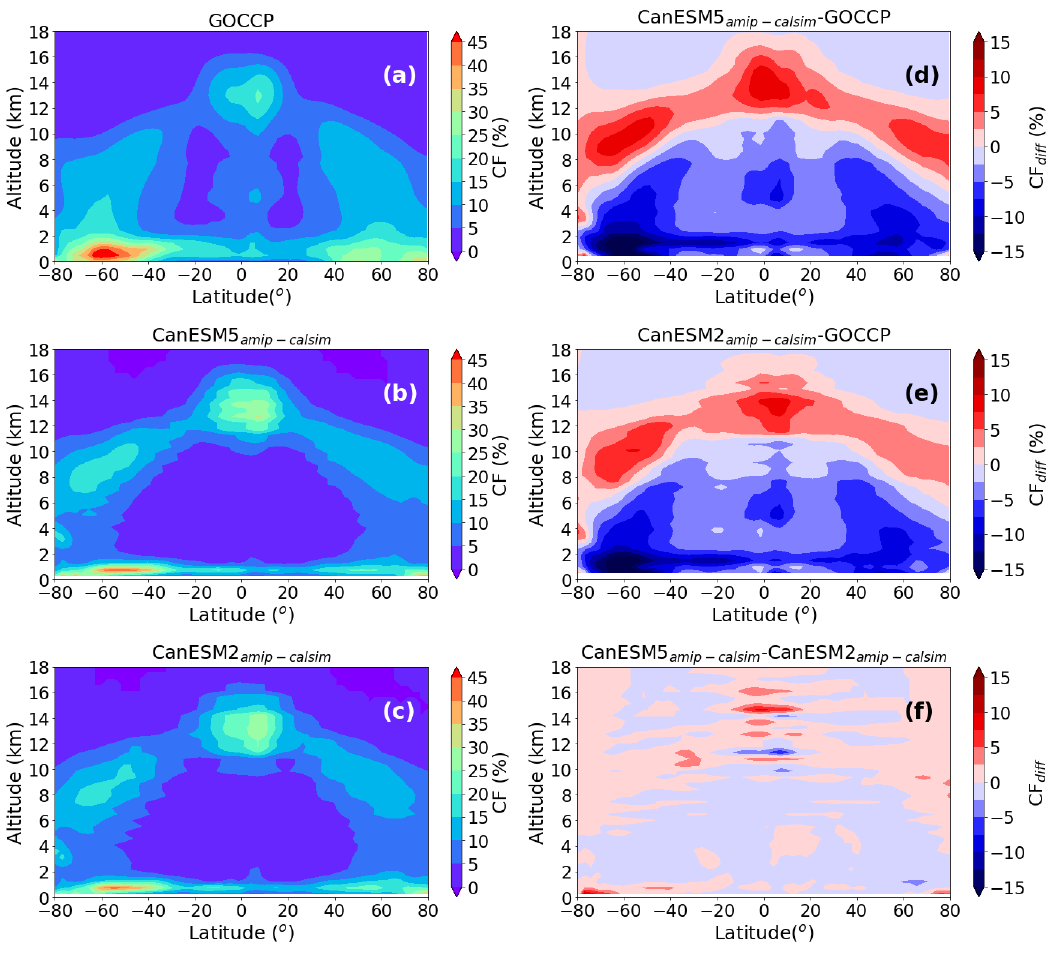
Figure 8. Annually and zonally average vertical cross-section of CF based on CALIPSO (panel ( a )), CanESM5 amip−calsim ( b ), CanESM2 amip−calsim ( c ) and the difference (model-CALIPSO) for CanESM5 amip-calsim ( d ), CanESM2 amip-calsim ( e ), and CanESM5 and CanESM5 amip - CanESM2 amip ( f ).